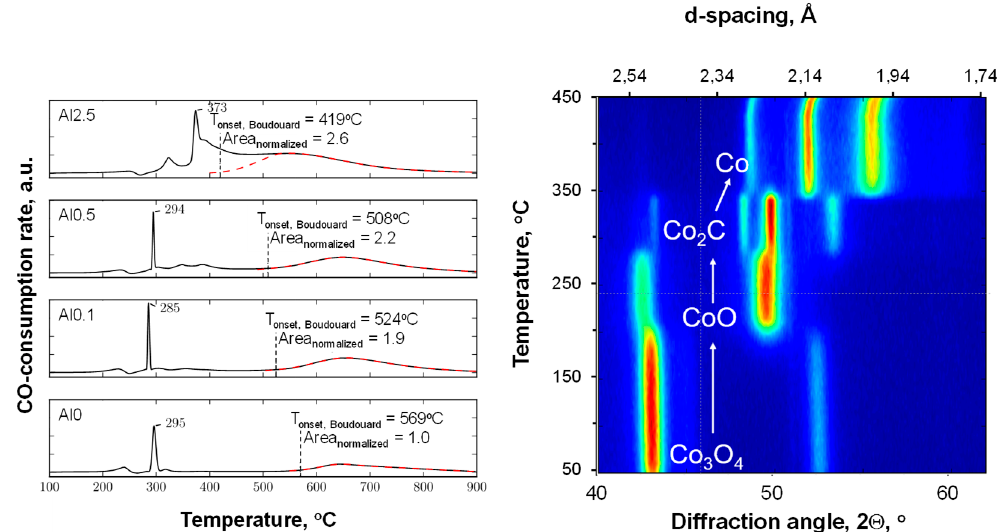
Figure 3. CO-TPR profiles (left) and the corresponding in situ XRD reduction experiments of Al0 using carbon monoxide as the reducing agent (right).